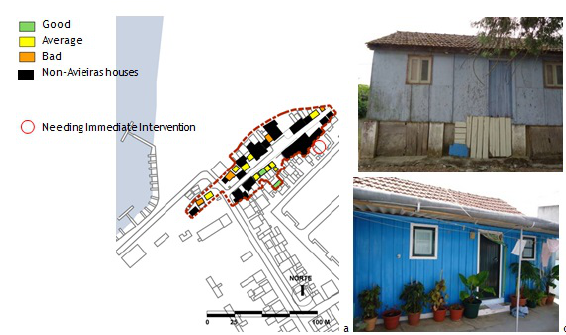
Figure 6: ICT platform application for evaluation of status of wooden stilt-houses conservation, in Escaroupim: a. vernacular stilt-house village of Escaroupim; b. the worst case of status of building conser- vation (corresponding to the wooden stilt-house no. 1); c. the best case of status of building conservation (the single-story house no. 29a).